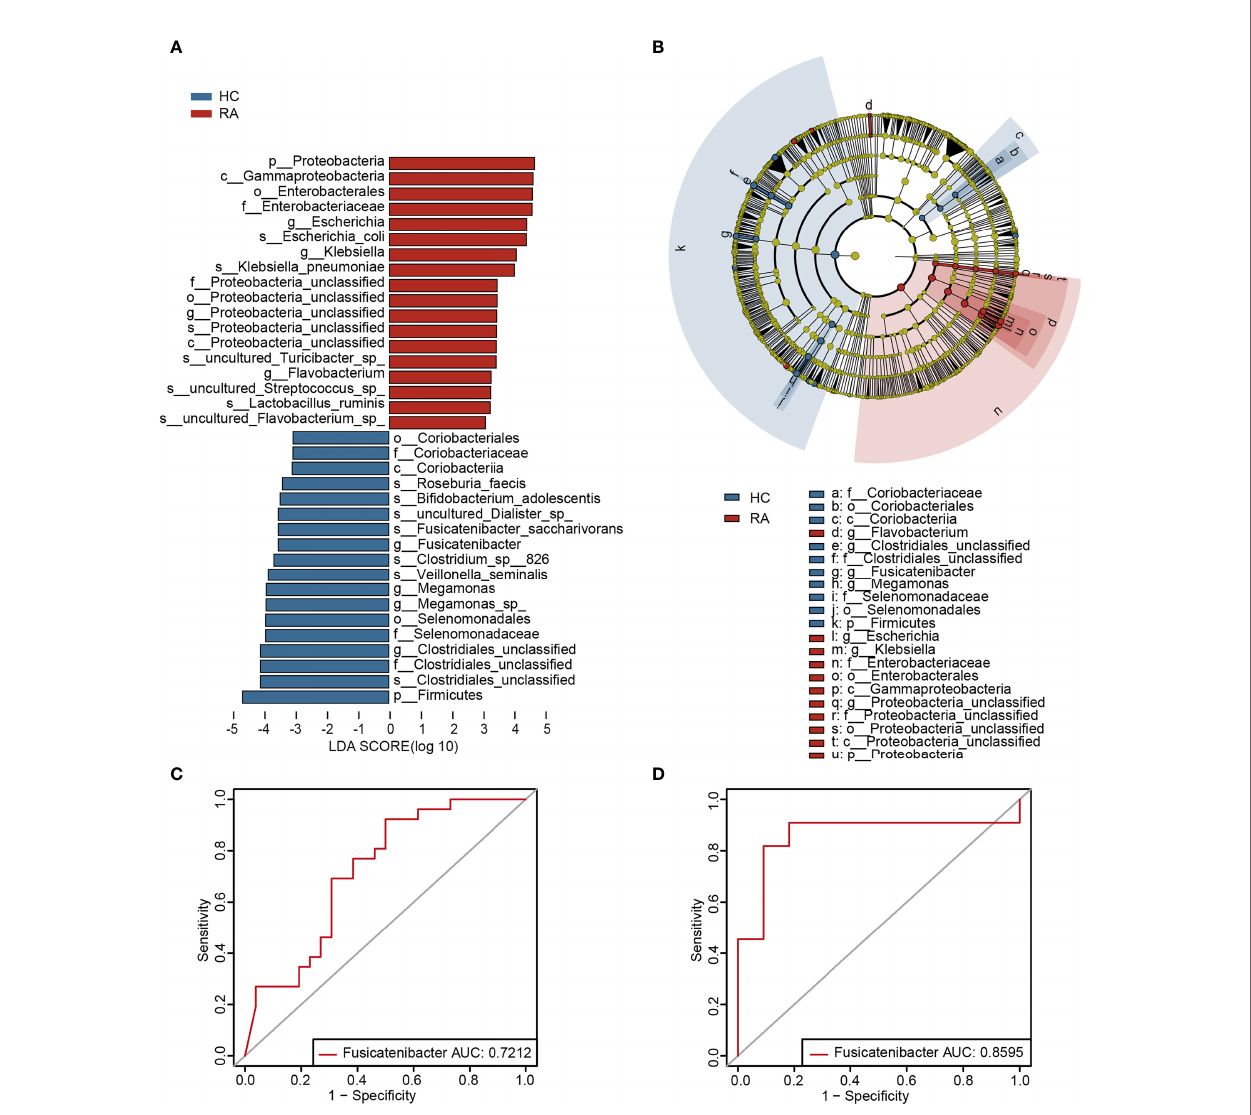
FIGURE 2 | The speci fi c altered taxa were identi fi ed by linear discriminant analysis (LDA) effect size (LEfSe) analysis. (A) The histogram of taxa with LDA scores more than 3 and p-value less than 0.05. (B) The phylogenetic tree in cladogram of the speci fi c differential taxa. (C) ROC curve of Fusicatenibacter in test cohort. (D) ROC curve of Fusicatenibacter in validation